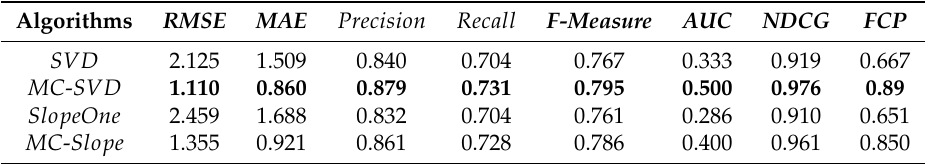
Table 9. Evaluation results for experiment two.